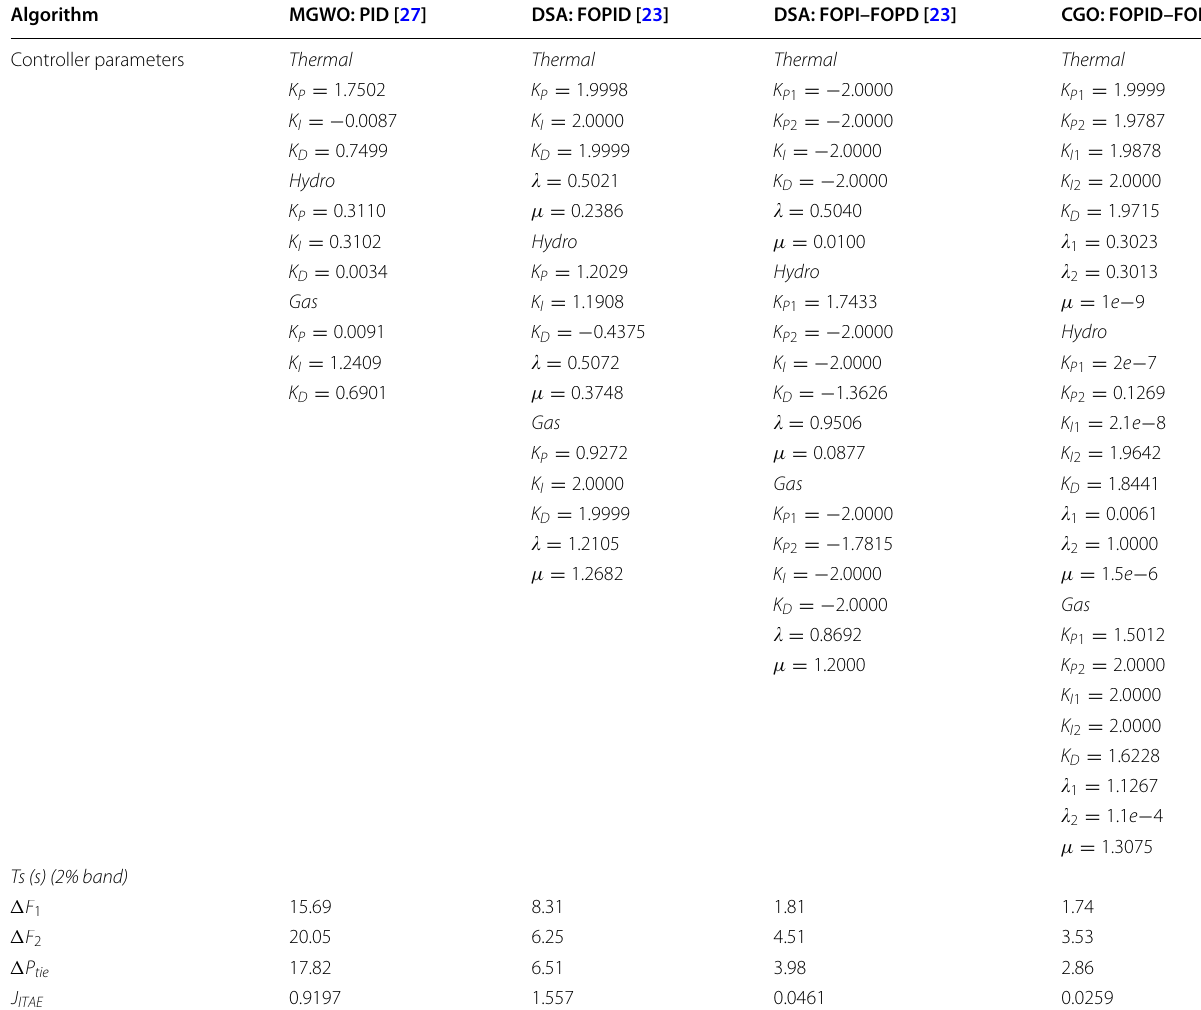
results of Test-system-3 ITAE